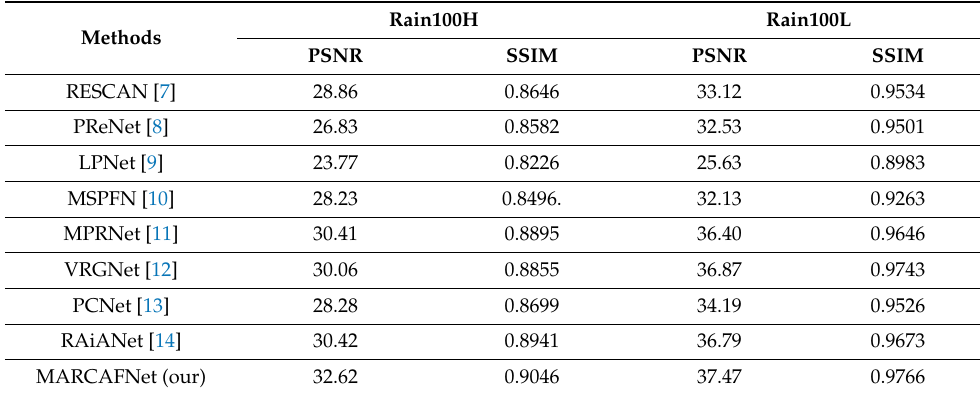
Table 2. PSNR and SSIM quantitative comparison of the proposed MARCAFNet with state-of-the-art